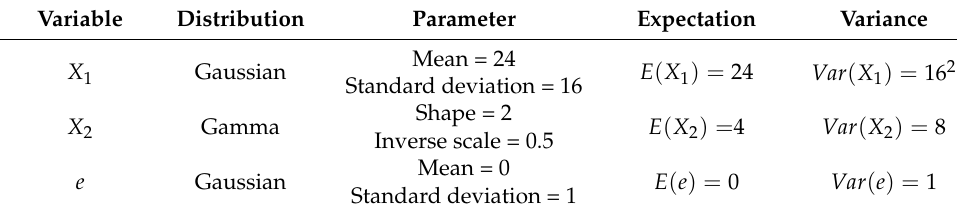
Table 2. Probability distributions for generating simulation